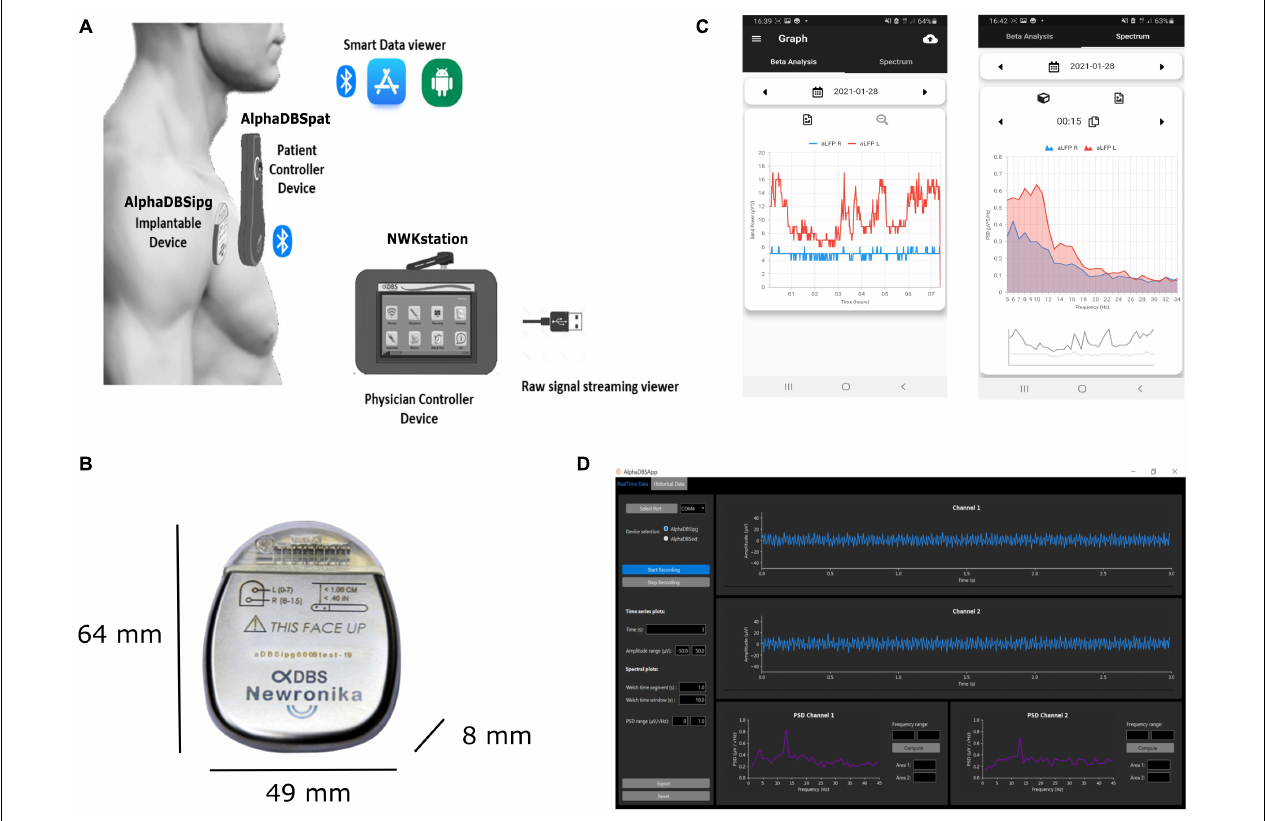
FIGURE 2 | AlphaDBS System architecture. (A) AlphaDBS System components: the AlphaDBSipg implantable device is recharged using a patient controller (AlphaDBSpat) that also allows downloading data and signals recorded using the embedded mode. A mobile app allows data visualization. The physician controller device (NWKstation) is used to program the AlphaDBSipg and to visualize LFPs recorded in the streaming mode. (B) AlphaDBSipg dimensions. (C) Screenshot of the mobile app showing beta band amplitude time changes (on the left) and power spectrum at a given time point (on the right). (D) Python-based GUI for real-time LFPs processing, visualization, and